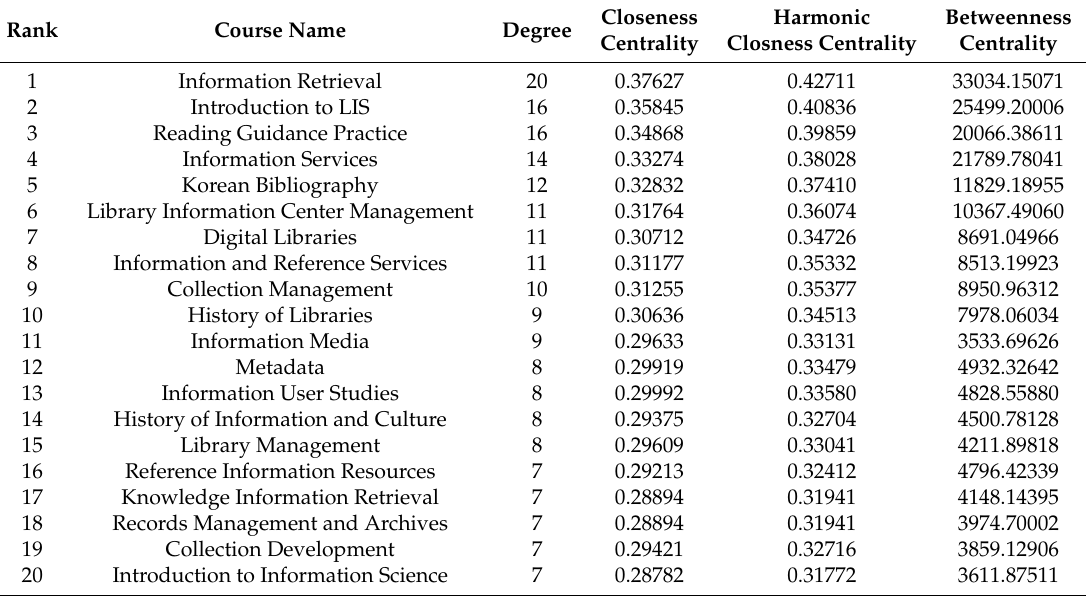
Table 4. Betweenness centrality and closeness centrality of the top 20 courses according to a network